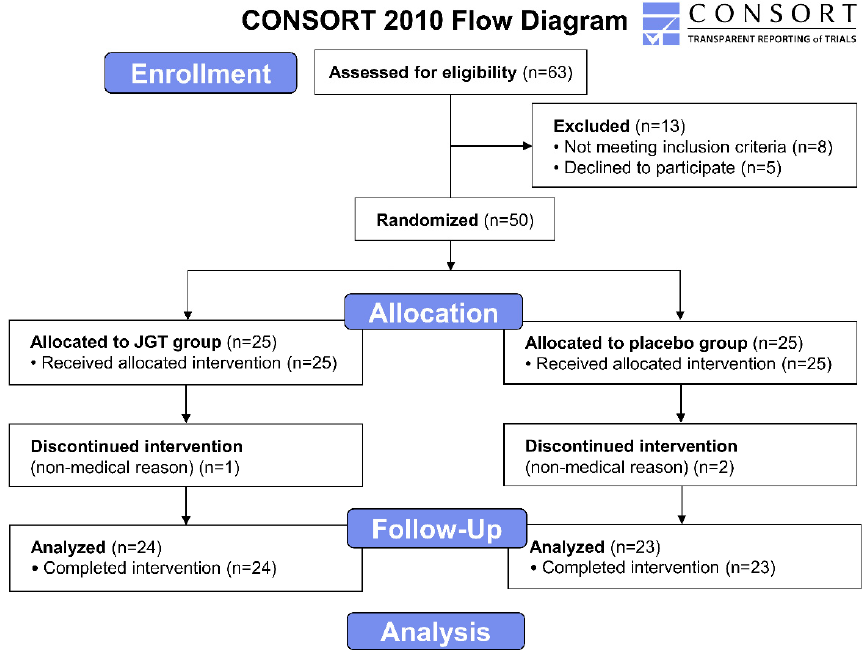
Figure 4. CONSORT 2010 flow diagram of the clinical trial. The phases of the trial, screening, enrolment, randomization, follow up, and data analysis are demonstrated on the flow diagram. A total of 63 subjects diagnosed with CSD were recruited at first. After the exclusion of 13 subjects, 50 subjects in total were divided between the JGT group ( n = 25) and placebo group ( n = 25), and JGT or placebo was administrated to all participants in each group for 4 weeks. The assay results of the participants who completed the procedure ( n = 24 for the placebo group and n = 23 for the JGT group) were included to be analyzed. CSD: chronic subjective dizziness; JGT: Jaeumgeonbi-tang . Serum NO levels were analyzed using a commercial kit and the manufacturer’s in- structions (Nitric Oxide Colorimetric Assay Kit, BioVision, Milpitas, CA, USA, Catalog no.: K262). Serum levels of MDA, a byproduct of oxidative stress, were measured by TBARS assay using the previous method [44]. In brief, 75 μ L of serum sample was added to microcentrifuge tubes and mixed with 3 μ L of butylated hydroxytoluene in methanol. Next, 75 μ L of 1M phosphoric acid and an equal volume of 2-thiobarbituric acid were added and then mixed in the same tube using the vortex. The tubes were then incubated for 60 min at 60 °C. Following incubation, the mixture was added to a microplate (100 μ L of each), and the absorbance at 535 and 572 nm (to correct for baseline absorption) was measured with a spectrophotometer (Versa Max. Molecular Device, Sunnyvale, CA, USA). Tetra-methoxy-propane was used as a standard solution for the quantification anal- ysis calibration curve. The GSH levels in the serum were determined using a previously described method [45]. Briefly, in a 96-well plate, either 50 μ L of dilute serum (in 10 mM PBS, pH 7.2) or reduced GSH (as a standard) was mixed with 80 μ L DTNB/NADPH mixture (10 μ L, 4 mM DTNB, and 70 μ L, 0.3 mM NADPH). Then, to each well in the plate, 20 μ L (0.06 U) of GSH-reductase solution was added, and absorbance at 405 nm was measured using a plate reader. The serum antioxidant capacity was determined using the TEAC method which was slightly modified from the previous description [46]. Amounts of 90 μ L of 10 mM PBS (pH 7.2), 50 μ L of myoglobin solution (18 uM), 20 μ L of 3 mM ABTS solution, 20 μ L of a dilute serum sample, or different concentrations of Trolox (as a standard) were mixed together for 3 min at 25 °C in a 96-well microplate. After then, each well received